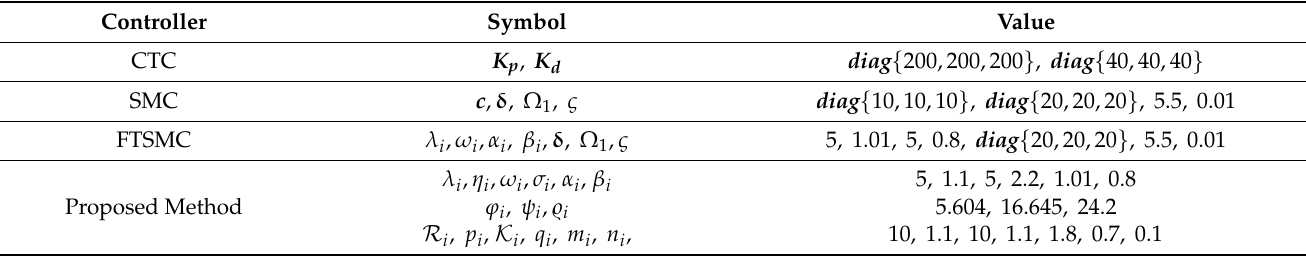
Table 3. The selected parameters of three controllers.